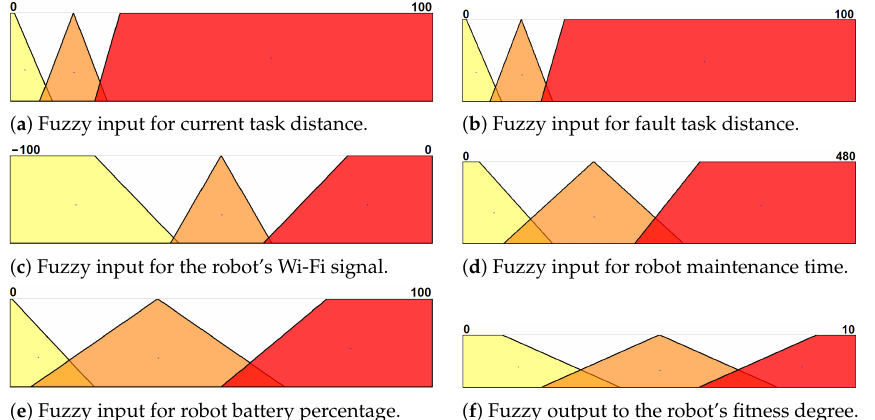
Figure 5. Inputs and outputs for the Fuzzy consensus